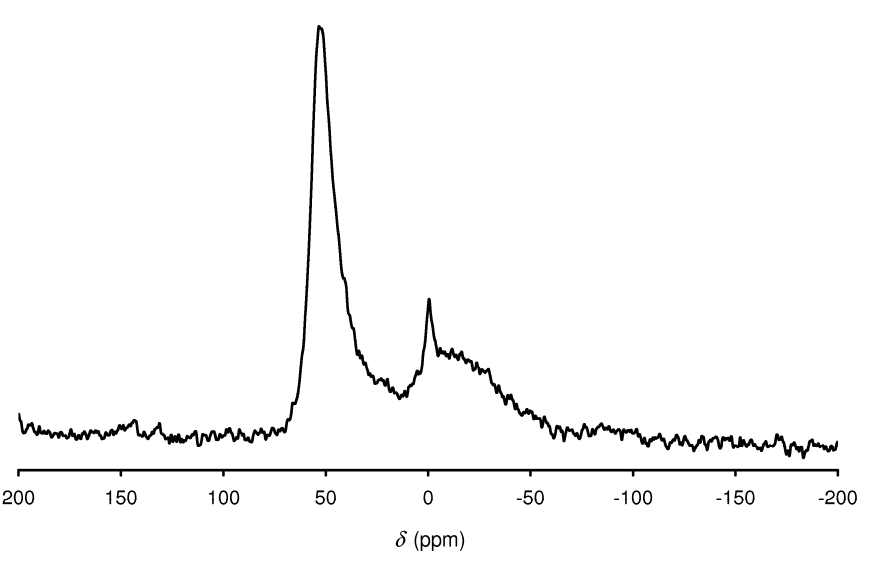
Figure 4. 27 Al MAS NMR spectrum of